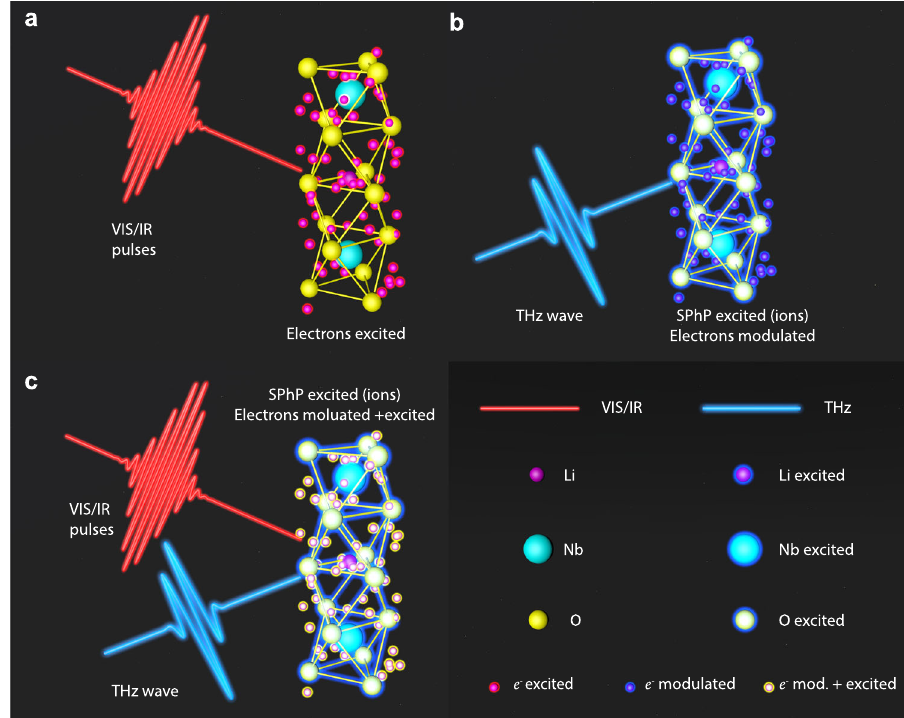
Fig. 1 Diagram of stimulated phonon polariton-mediated light – matter interaction (SPhP-LMI) in LiNbO 3 crystal. a Traditional LMI mechanism. Only electrons can be excited when visible/infrared light inputs the LiNbO 3 crystal, and the ions are hardly excited. b SPhP-LMI mechanism excited by THz waves. SPhPs are excited when THz waves input the LiNbO 3 crystal. The ions are modulated by SPhPs and show strong coherent delocalization, where electronic states are changed accordingly through ion-electron coupling. This indicates a distinct LMI between THz waves and LiNbO 3 crystal, beyond Born – Oppenheimer approximation. c SPhP-LMI mechanism excited by visible/infrared light with THz waves exciting SPhPs. Electronic states are thus modulated by the SPhP-induced coherently delocalized ions, so the visible/infrared light performs a different excitation, which results in a dramatical material modulation and fi nds a distinctive approach to achieving weak-light nonlinear photonics. Here Born – Oppenheimer approximation is not